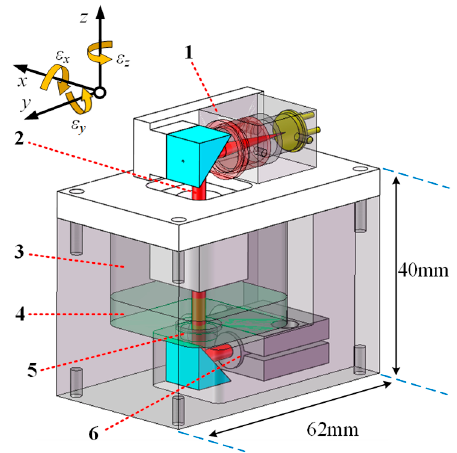
Figure 2. Structure design of the refractive precision level sensor: (1) micro autocollimator unit, (2) reference laser beam, (3) container, (4) transparent liquid, (5) optical window, (6) laser diode.